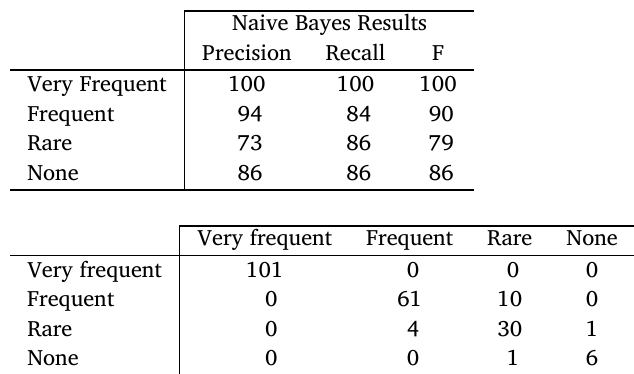
Confusion Matrix of Naive Bayes classifier for Dryer’s